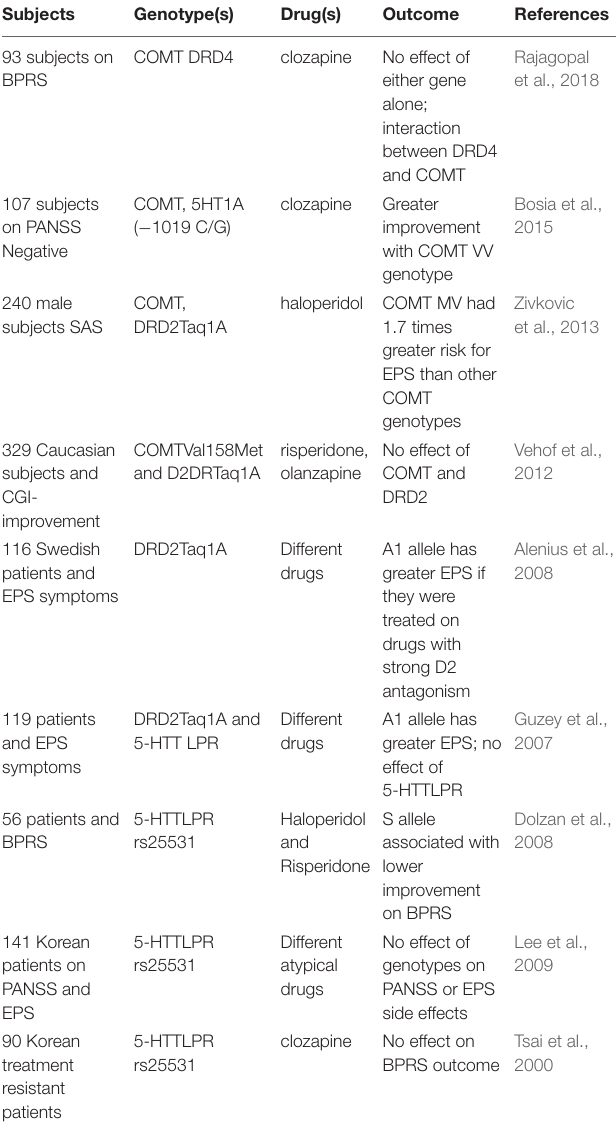
TABLE 1 | Clinical studies on the effect of COMTVal158Met, 5-HTTLPR, and DRD2Taq1A genotypes on antipsychotic clinical response to PANSS and motor side-effects in